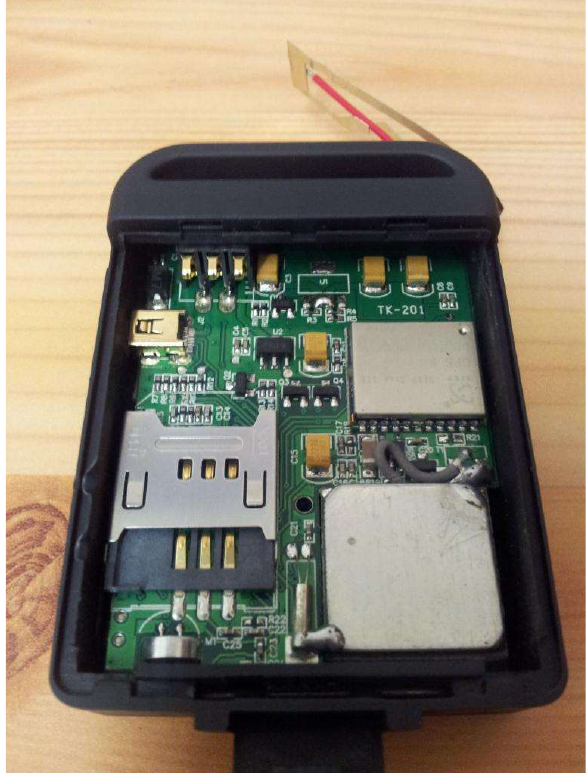
Figure 15. TK102B GPS/GSM tracker module—antenna at top.